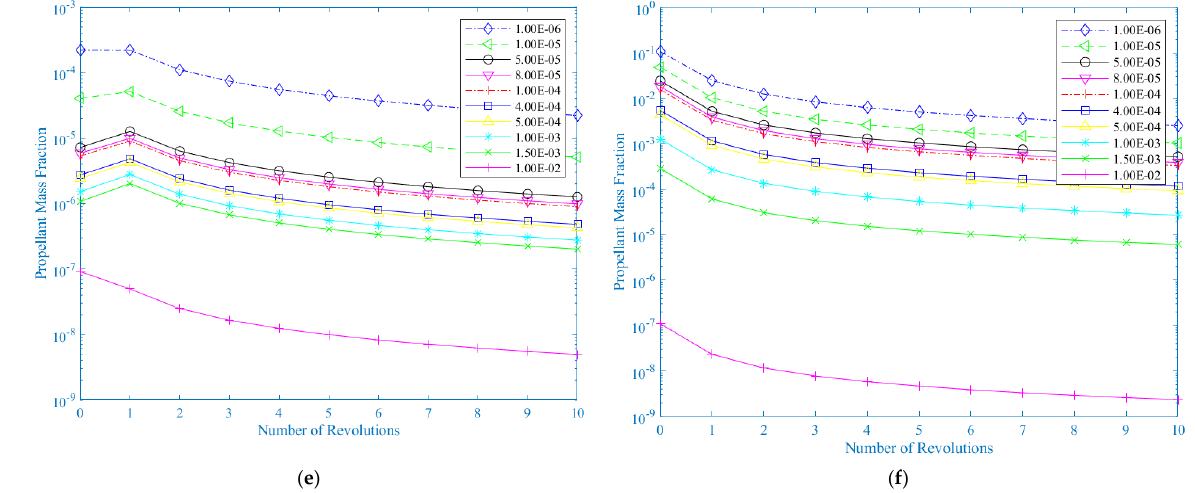
Figure 10. Propellant coefficients required for orbit change at different ACPL values during the revolution. ( a , b ) Comparison of different PMF variations with and without Starlink for GAOFEN; ( c , d ) Comparison of different PMF variations with and without Starlink for CORVUS BC5; ( e , f ) Comparison of different PMF variations with and without Starlink for YAOGAN−35C.